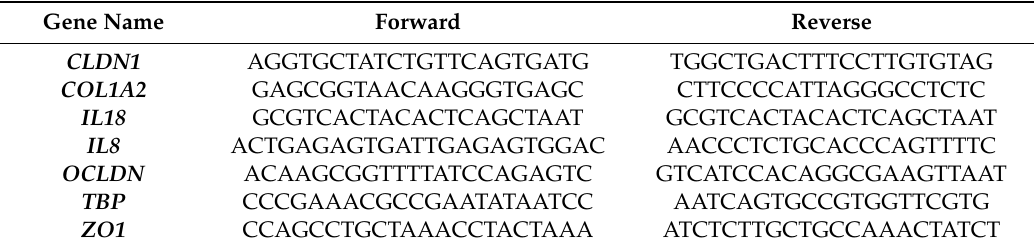
Table 1. Human primers sequences.